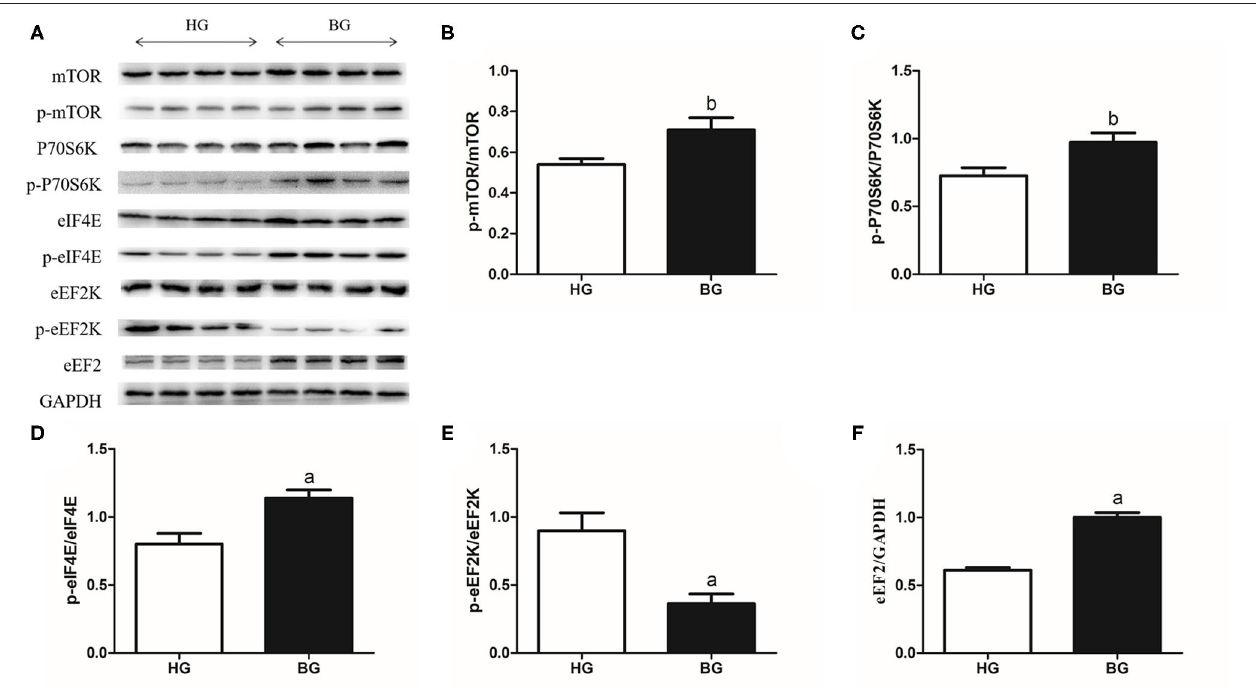
FIGURE 7 | Milk protein synthesis mTOR related signaling pathway protein expressions. (A) mTOR related signaling pathway protein expression levels were measured by western blotting analysis. (B) The ratios of phosphorylated to total mTOR were quantified by gray scale scan. (C) The ratios of phosphorylated P70S6K to total P70S6K were quantified by gray scale scan. (D) The ratios of phosphorylated eIF4E to total eIF4E were quantified by gray scale scan. (E) The ratios of phosphorylated eEF2K to total eEF2K were quantified by gray scale scan. (F) Relative protein levels of eEF2 from the western blots were quantified by gray scale scan. Values are mean ± SEM. n = 4/group. b p < 0.05 and a p < 0.01, compared with high grain